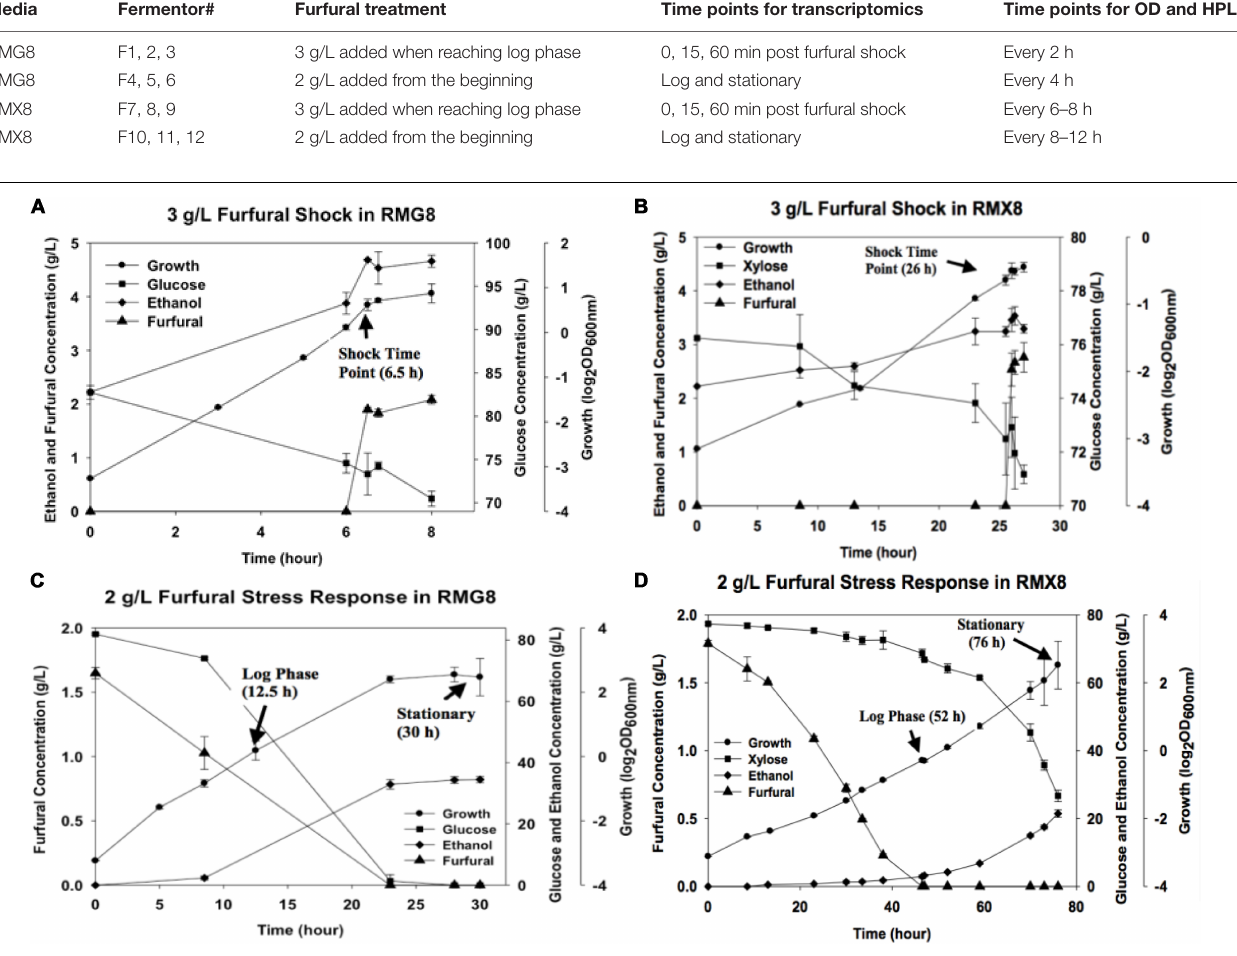
FIGURE 1 | Furfural concentration, cell growth, sugar utilization, and ethanol production in RMG8 or RMX8 media with furfural shock or stress. (A) Time course shock response with the supplementation of 3 g/L furfural at log phase in RMG8; (B) time course shock response with the supplementation of 3 g/L furfural at log phase in RMX8; (C) stress response with the supplementation of 2 g/L furfural from the beginning of fermentation in RMG8; (D) stress response with the supplementation of 2 g/L furfural from the beginning of fermentation in RMX8.